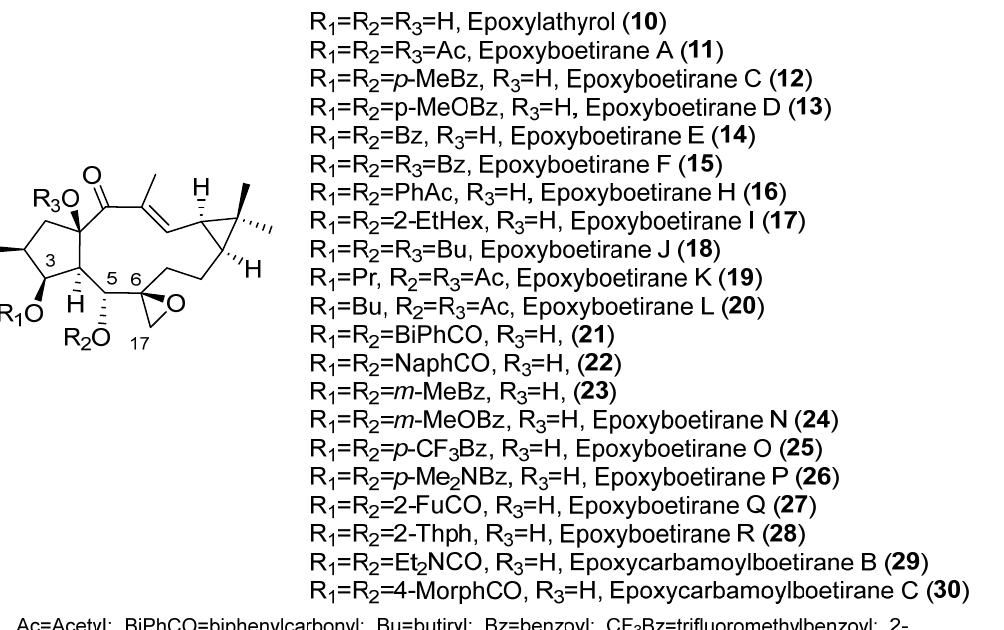
Figure 4. Chemical structures of 6,17-epoxyboetirane derivatives (compounds 10 – 30 ) with MDR- modulating activity.